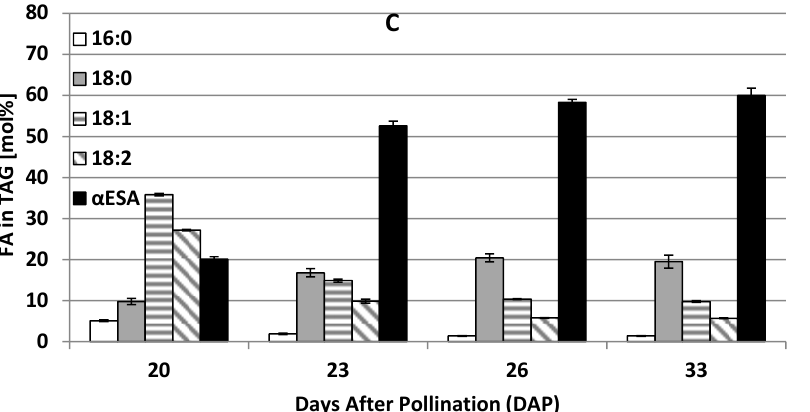
Figure 3. Fatty acid composition of polar lipids ( A ), diacylglycerols ( B ) and triacylglycerols ( C ) of Momordica charantia developing seeds. Mean values and standard deviations ( n = 3) are presented (significant differences between the preceding and the following stage of seed development are presented in Table S2).